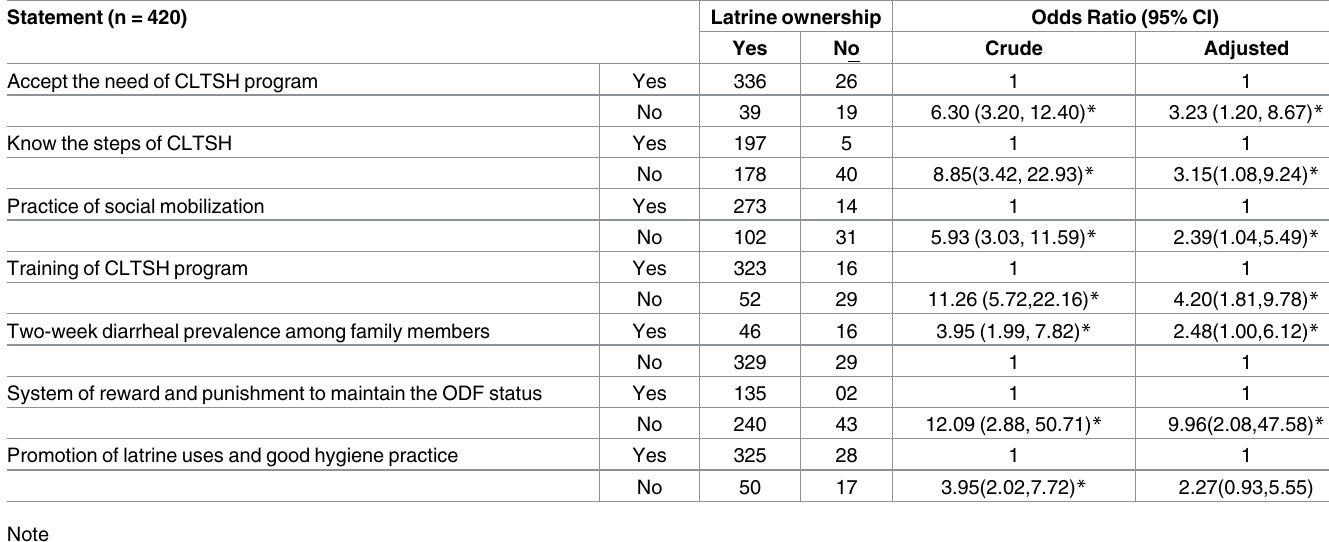
Table 3. Selected variables as measuredby latrine ownership among study participants in Diretiyara district, Ethiopia, 2014.